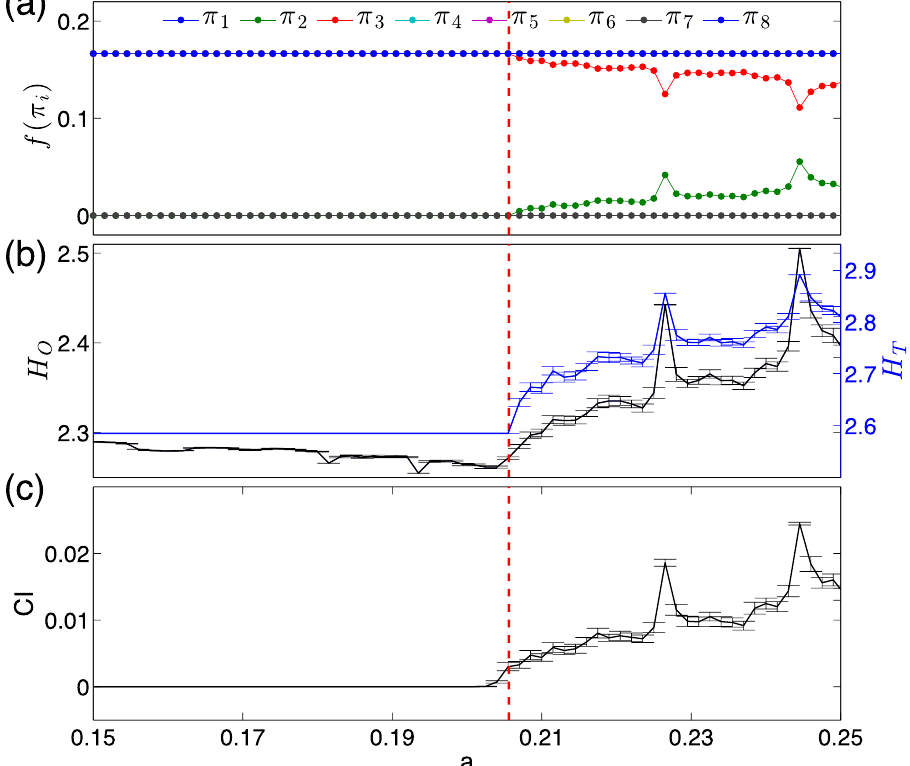
Figure 7. Phase coherence to non-phase coherence transition for the Rössler system as a function of the parameter a (error bars indicate standard deviations obtained from 100 independent realizations of the system for each value of a : ( a ) frequency of each ordinal pattern f ( π i ), where π 1 , π 4 , π 5 , π 6 and π 8 are overlapped in the  , ( c ) coherence index (CI). The transition from phase coherent entire range of a . ( b ) Entropy values  and O T to non-coherent is highlighted by the vertical dashed